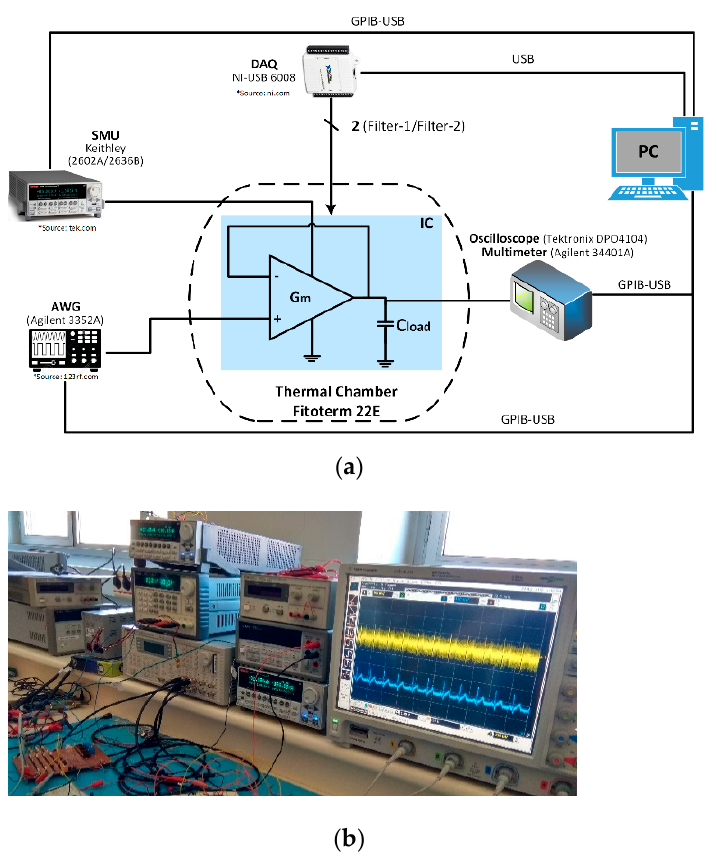
Figure 8. Automatic measurement setup for the two proposed LPFs: ( a ) block diagram and ( b ) experimental setup.